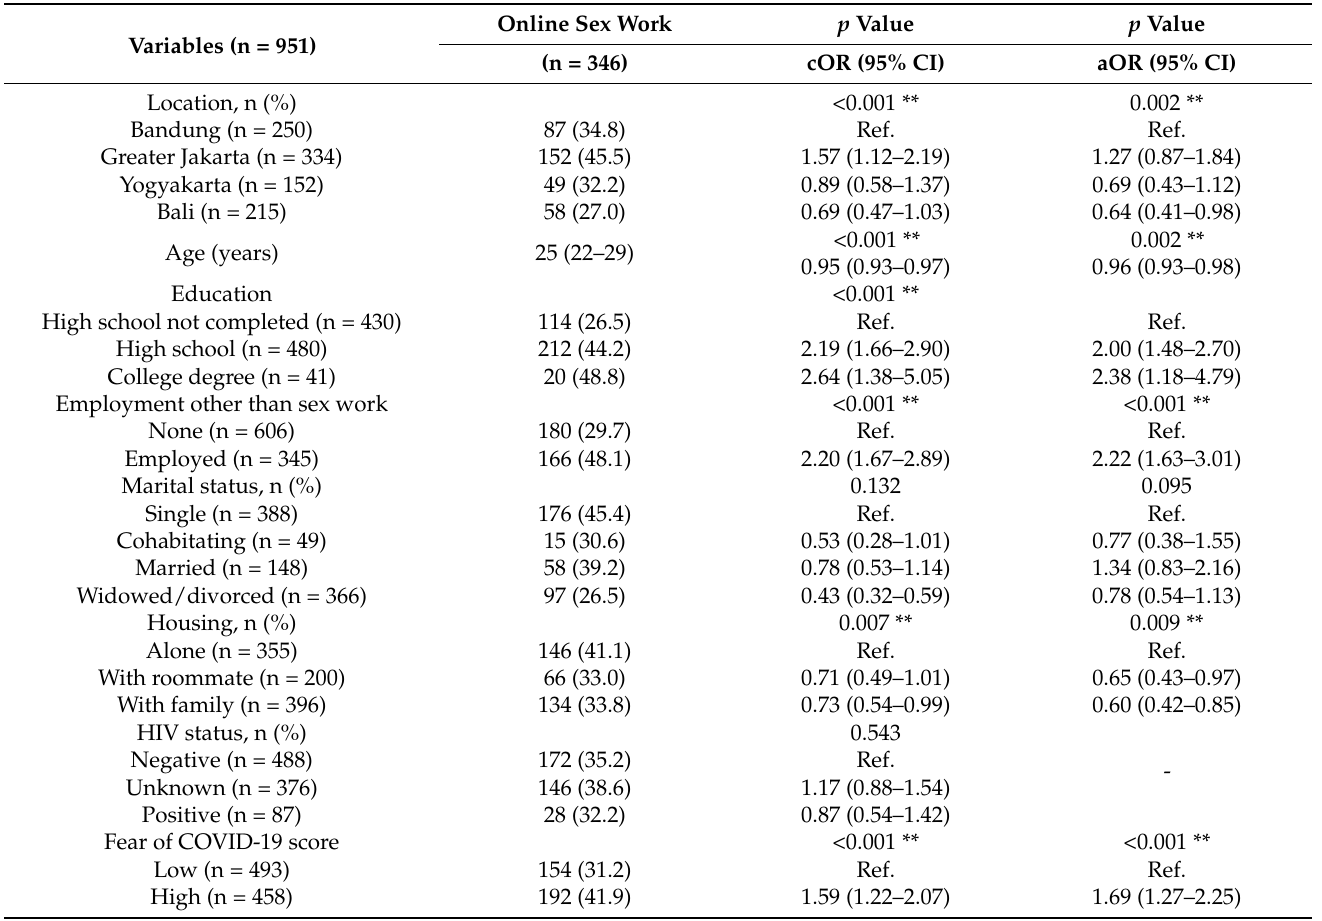
Table 2. Determinants of taking up online sex